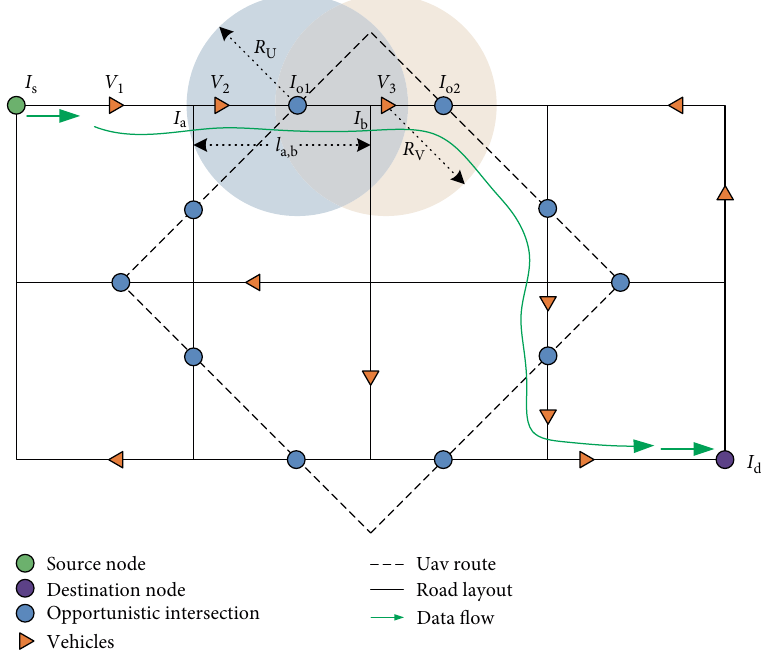
Figure 2: A geometrical model of UAV-assisted vehicular